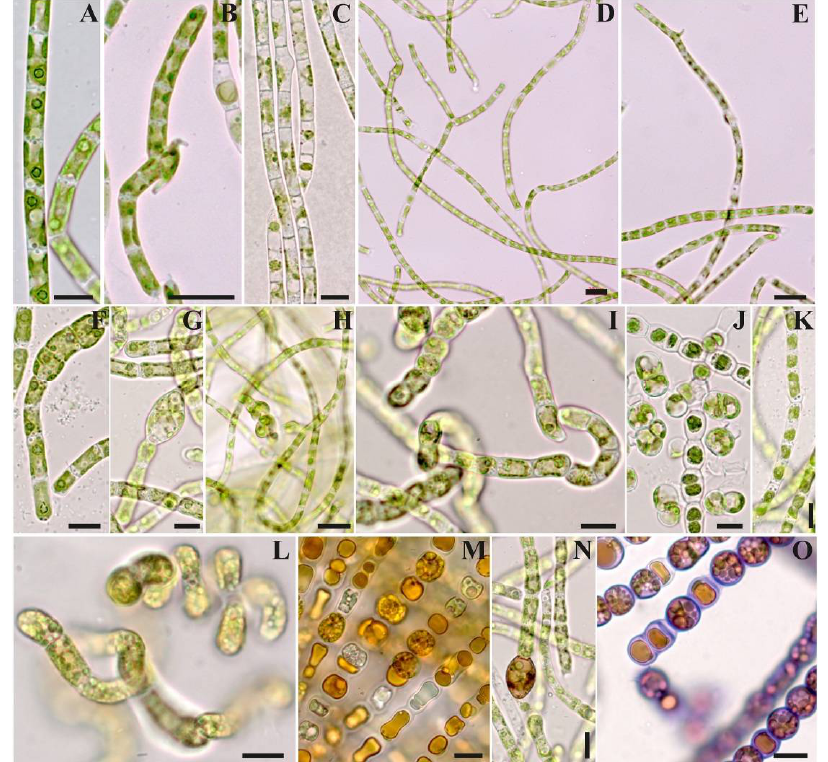
Figure 4. Morphology of filaments of the strain IRK–A 341 on the different stages of development. ( A – O ). Filaments of different shape and age; cells of different shape and sizes. ( B , D , E ). Branching. ( F – H , J ). Filaments with dividing cells, and forming two or more rows of cells. ( K ). Fragmented filaments with the formation H-pieces. ( M – O ). Resting cells of different shape. Scale bars: ( A – C , F – O )—10 µm, ( C – E )—20 µm.